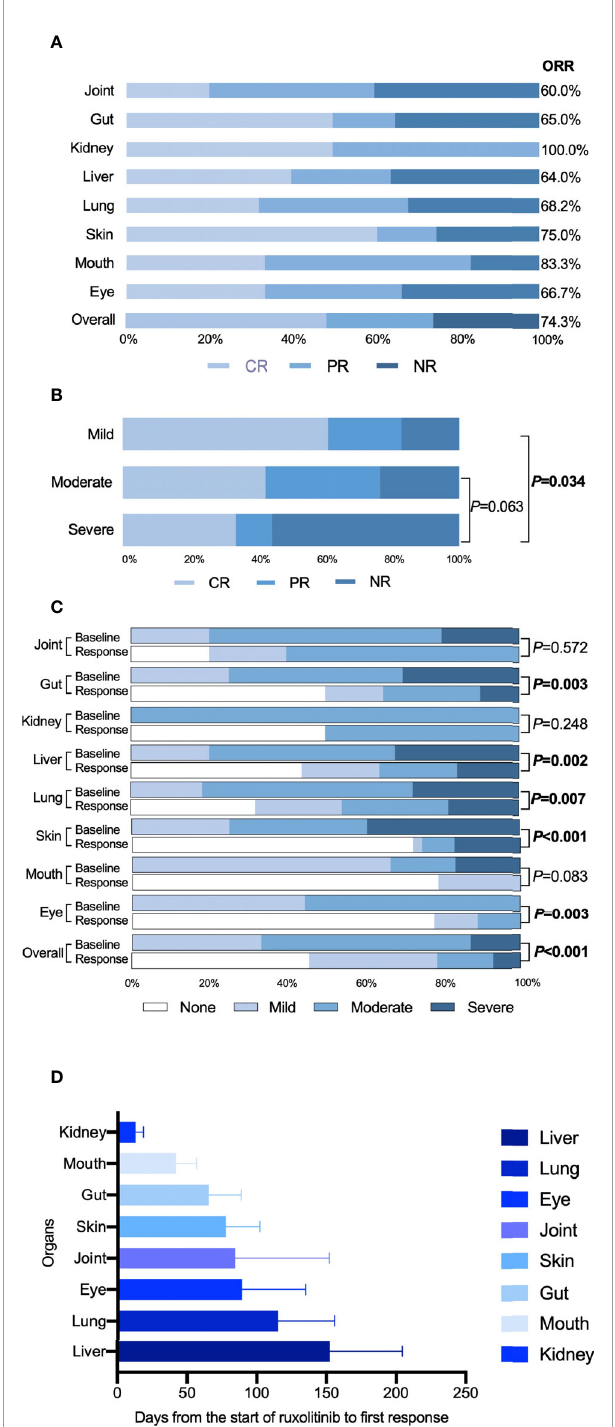
FIGURE 1 | Treatment ef fi cacy of ruxolitinib. (A) Response rates of different organs. (B) Comparison of treatment ef fi cacy among patients with mild, moderate and severe cGVHD. (C) Comparison of the cGVHD grades of different organs before and 24 weeks after ruxolitinib treatments. (D) Time, in days, from the start of ruxolitinib administration to the response of different